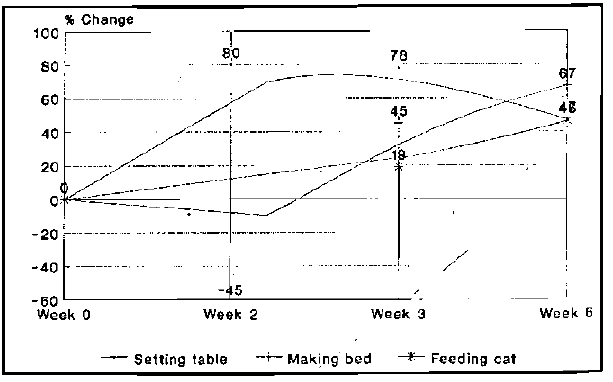
FIGURE 5: Mother: Selected sub-skills of communi- cation skills and skills at training the subject (all action routines) FIGURE 6: Mother: communication skills